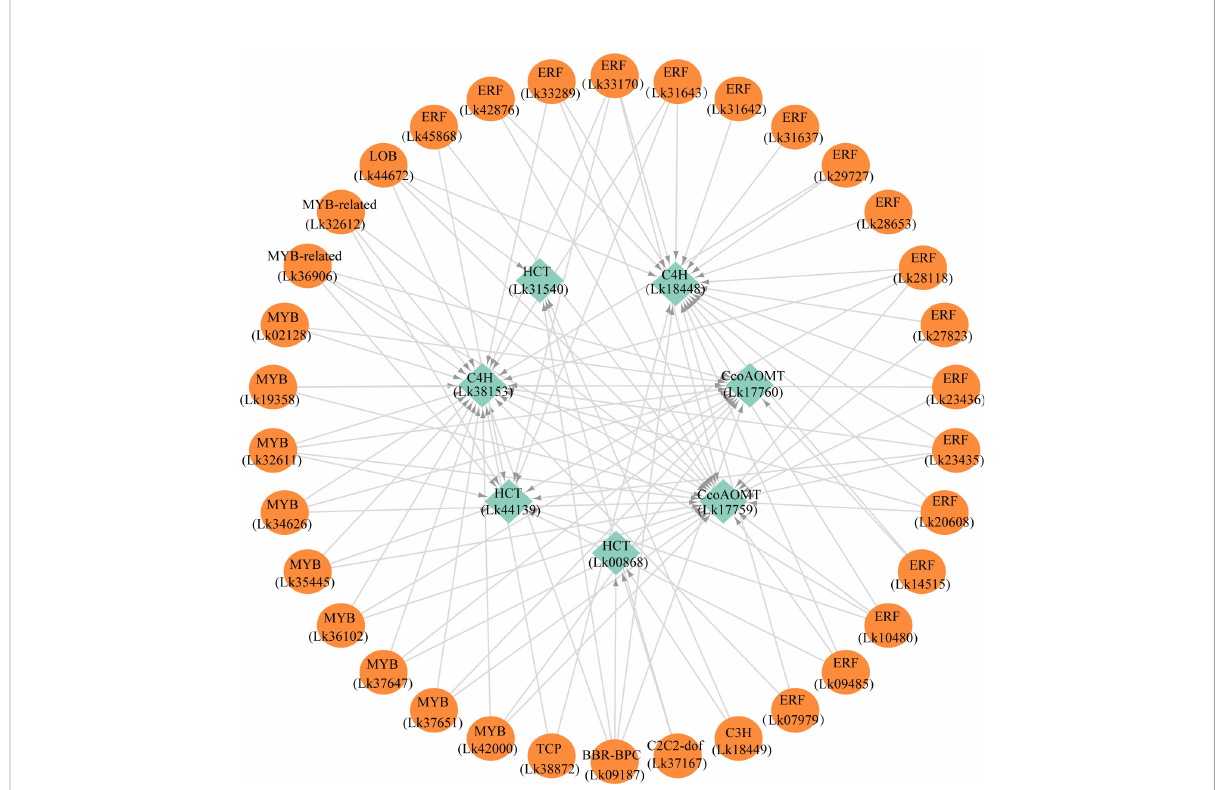
FIGURE 9 The potential regulatory network between TFs and key structural genes involved in phenylpropanoid and fl avonoid biosynthesis pathways in L. kaempferi callus.